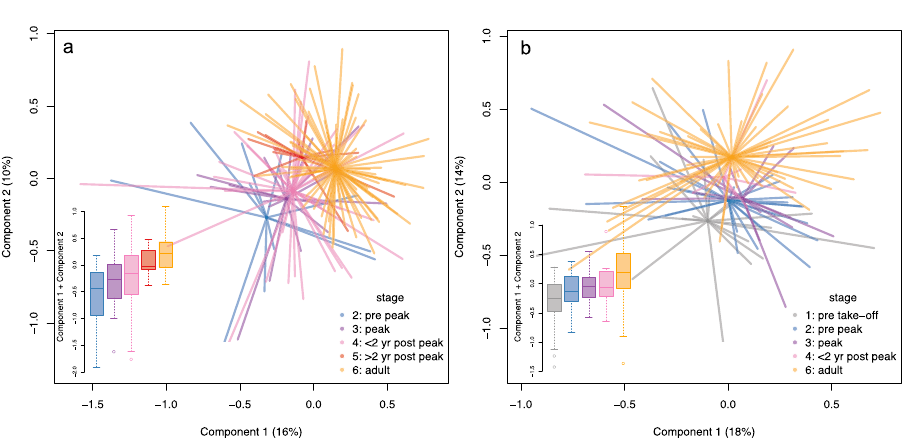
Figure 2. ( a ) Principal coordinates analysis of gut microbiota composition in girls compared with adults of the same sex. ( b ) Principal coordinates analysis of gut microbiota composition in boys compared with adults of the same